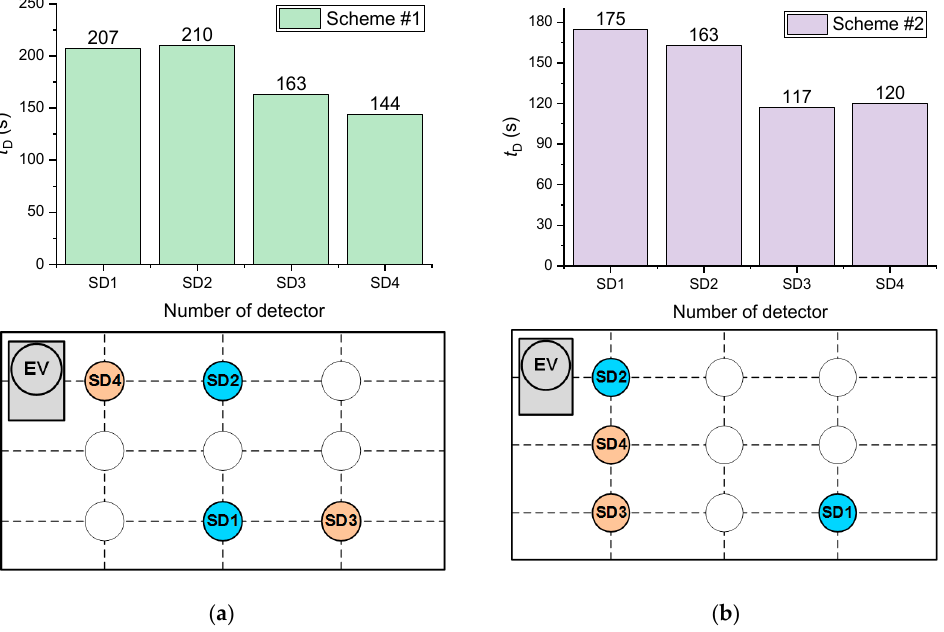
Figure 20. Average SD activation times during the combustion of wood for the two schemes under consideration: ( a ) Scheme #1; ( b ) Scheme #2.